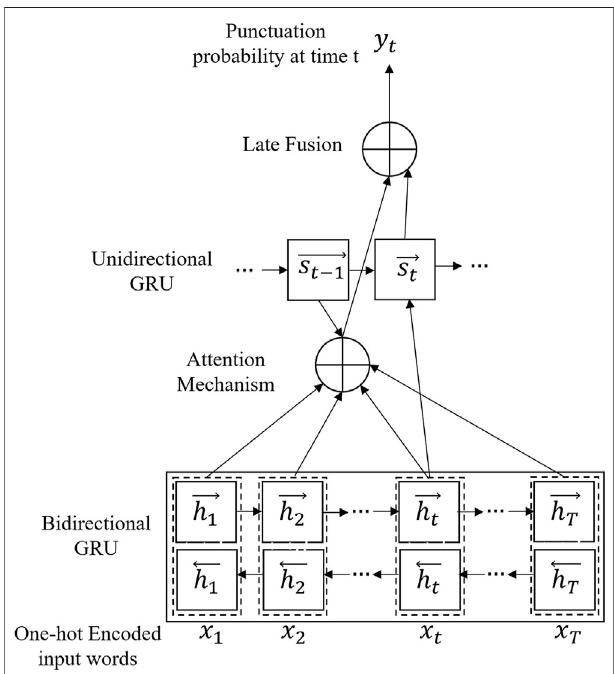
FIGURE 4 | The structure of the punctuation detection